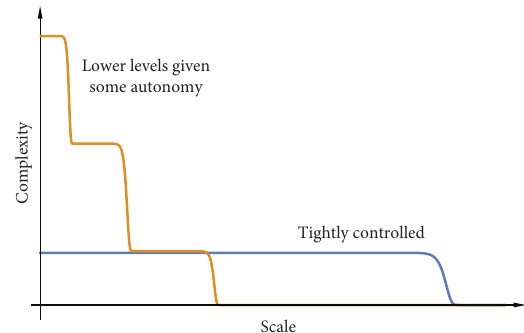
Figure 5: Complexity profiles of two hierarchies, each with the same number of people. Here, the scale is the number of coor- dinated man-hours. In one hierarchy, all decisions, regardless of the scale, are made by a single person, while in the other, different decisions are made at various levels of the